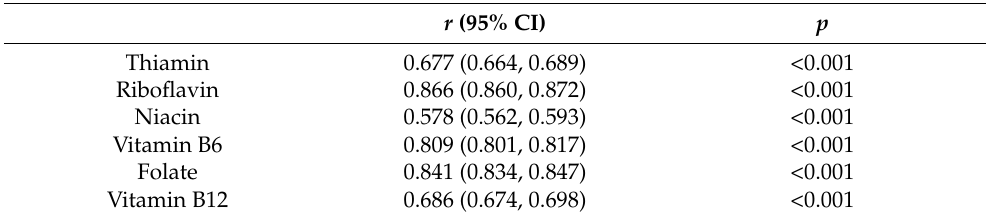
Table 1. Associations between the dietary pattern score derived by reduced rank regression and B vitamins